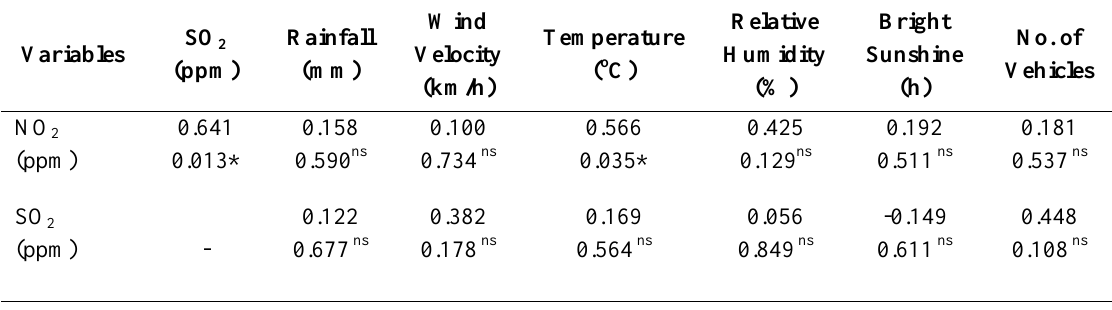
Table 3: Correlation coefficients and their p values between the pollutants and climatic and other parameters (bright sunshine, temperature, wind velocity, rainfall and number of